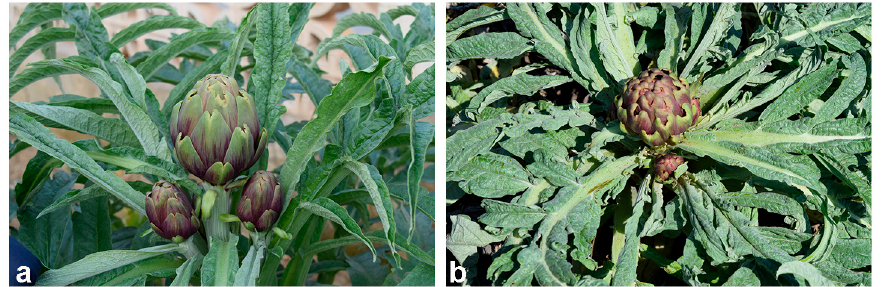
Figure 1. Artichoke biodiversity of late-flowering Apulian artichoke ecotypes ( a ) “Locale di Mola tardivo” and ( b ) “Troianella”.